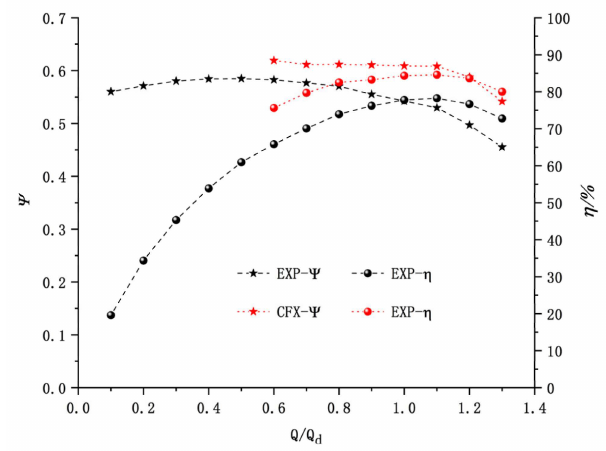
Figure 5. Comparison of the external characteristics. EXP stands for experimental data and CFX represents numerical simulation